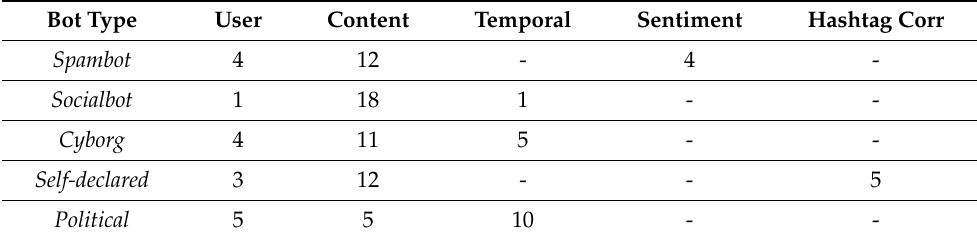
Table 8. Distribution of the 20 most important feature types for each bot type. Content features play an important role in almost every bot